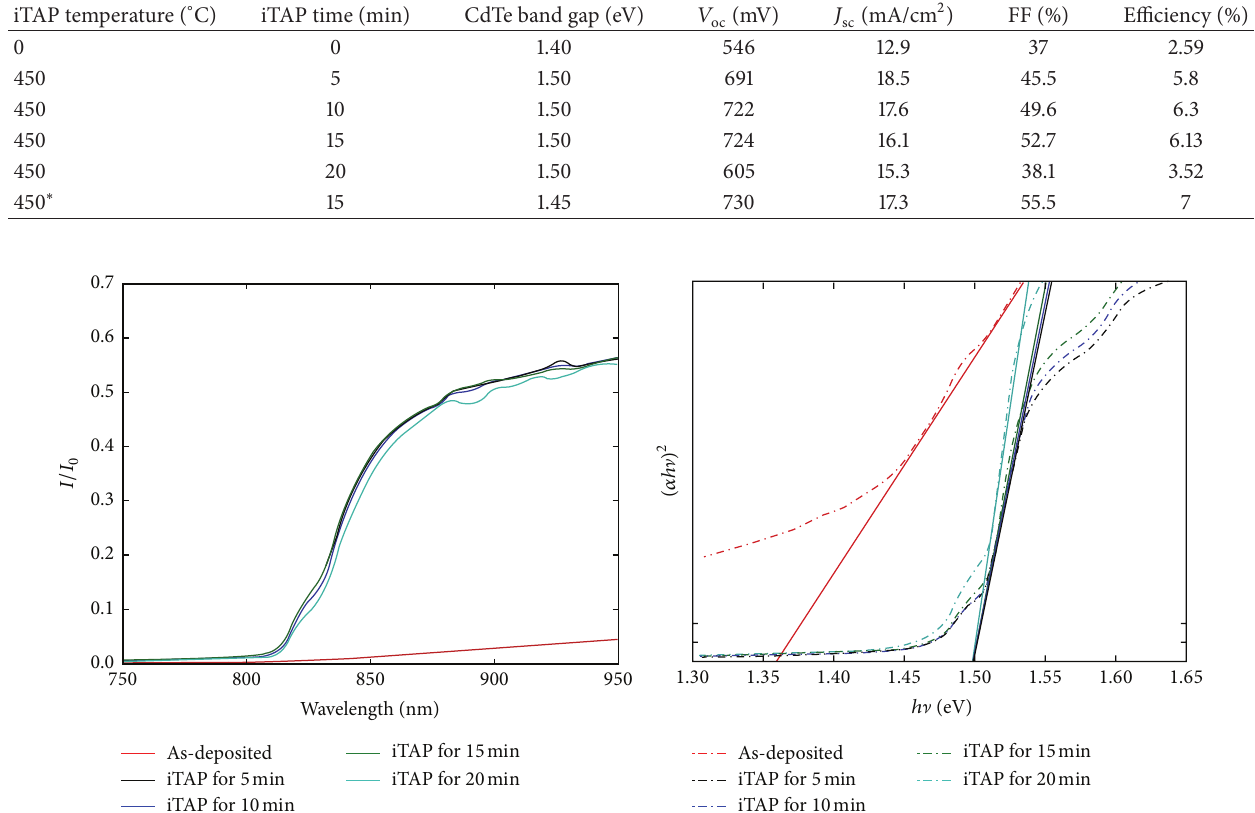
Table 1: Performances of thin film CdS /CdTe solar cells treated with iTAP at 450 ∘ C for various durations. ∗ CdTe thickness of 0.75 𝜇 m, while all others have CdTe thickness of 1.3 𝜇 m.